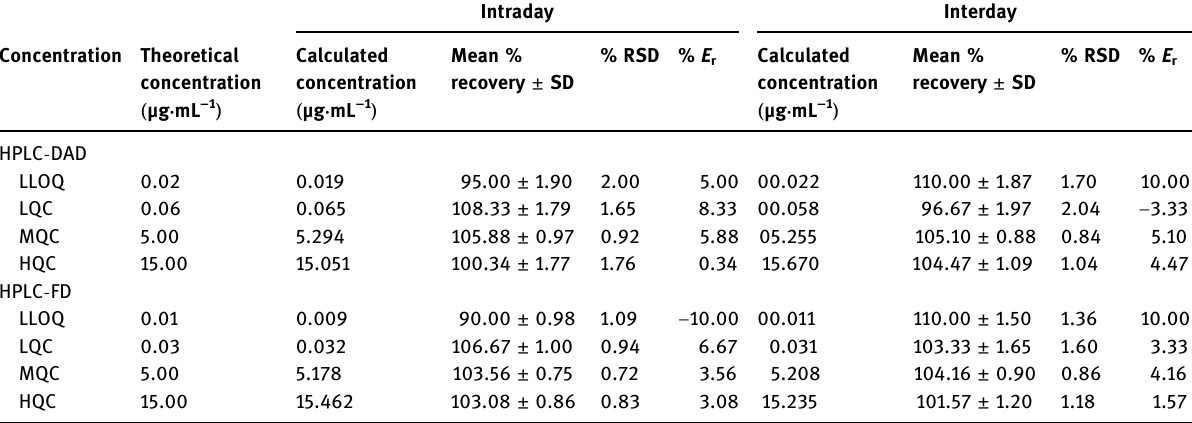
Table 3: Precision and accuracy assessment of the proposed method for determination of RM in human plasma ( n = 6 ) Intraday Interday Concentration